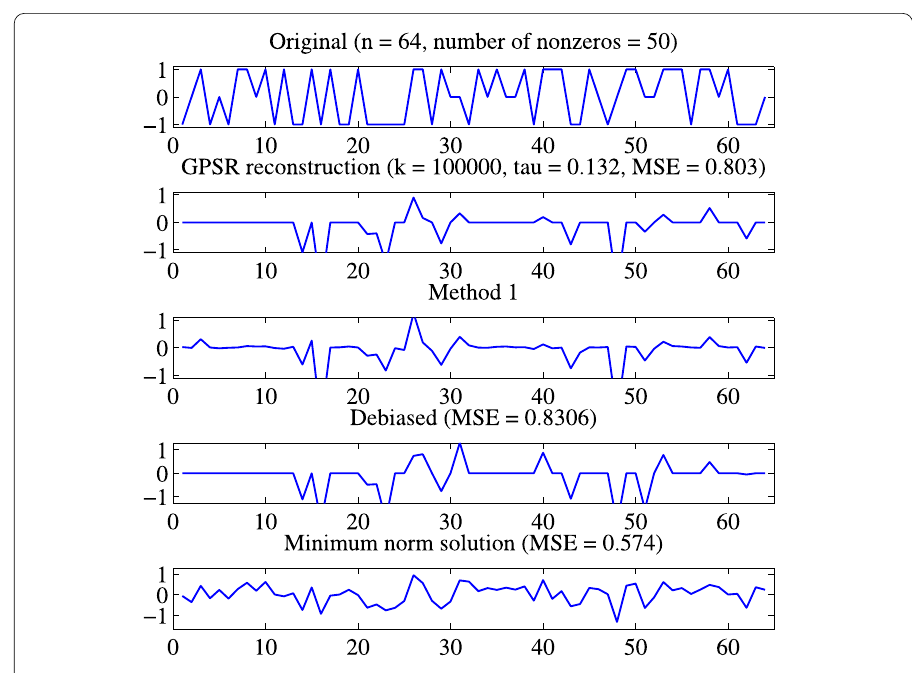
Figure 9 Numerical results for solving Example 5 with Algorithm